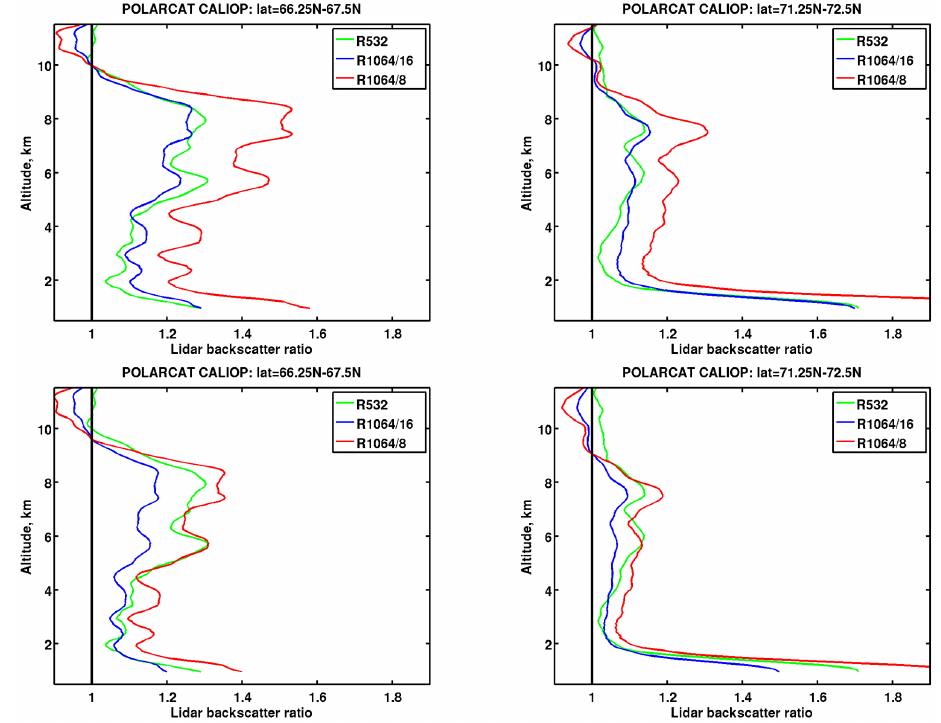
Figure 6. Mean attenuated backscatter ratio for the 532nm (green) and 1064 nm filtered level 1 CALIOP (blue and red). The 1064nm values are scaled to the 532nm values using expected lowest CR a = 0 . 5 (red) and largest CR a = 1 (blue). The top and bottom row respectively are for uncorrected and calibration corrected IR